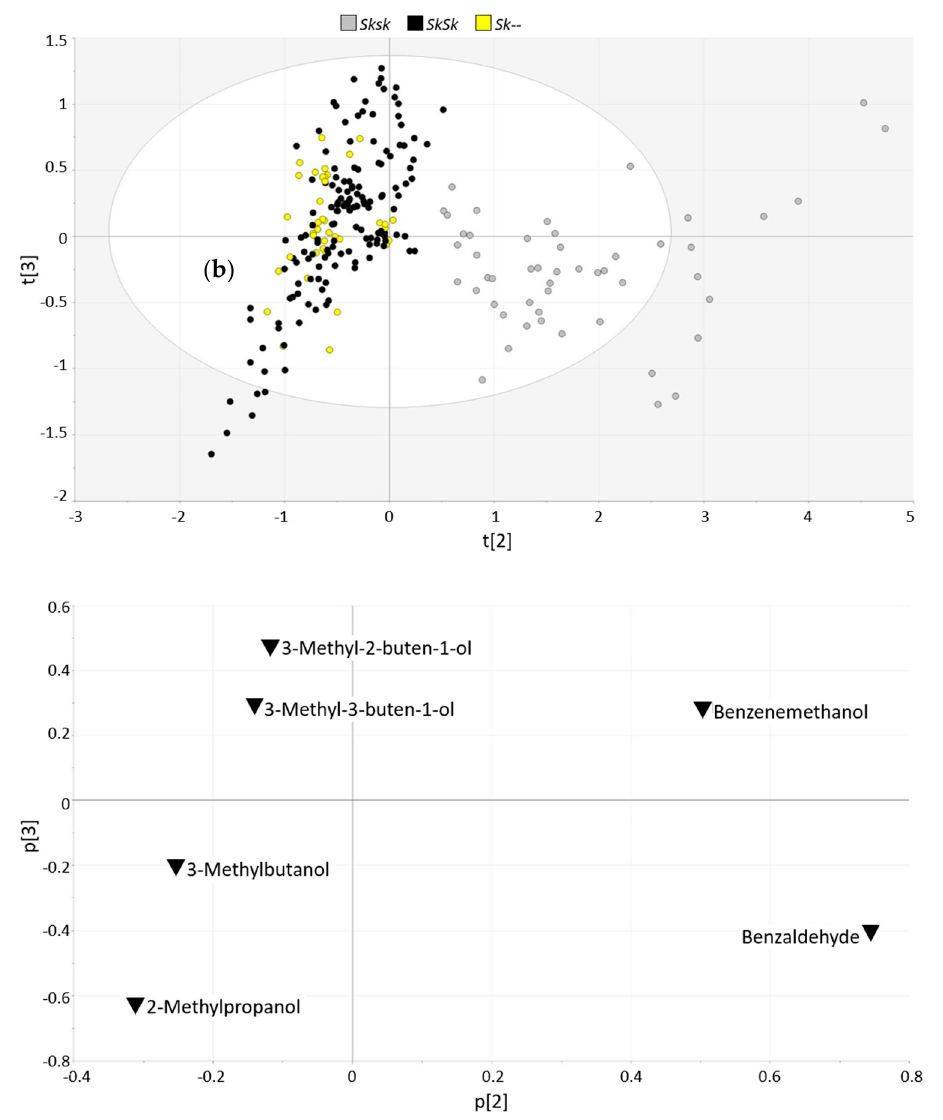
Figure 2. Principal Component Analysis (PCA) ( n = 242, 6 variables, scaled to unit variance, 3 PC, 94.7% total variance explained). ( a ) Scores plot and ( b ) loadings plot corresponding to PC2 and PC3 (19.6% and 4.8% total variance explained, respectively).